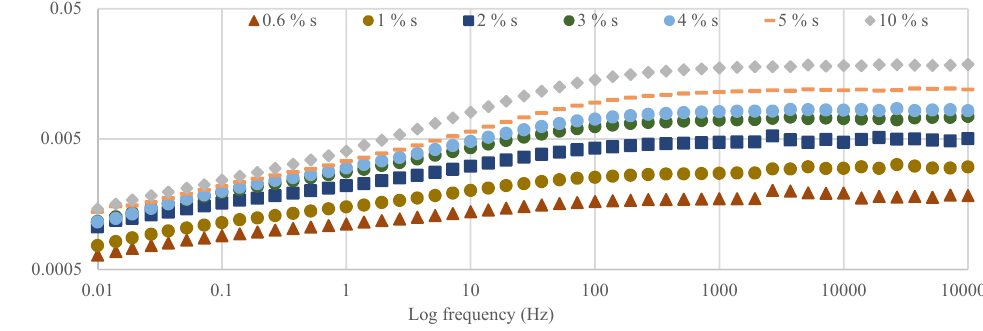
Figure 4. Conductivity of N solution (0.6%, 0.8%, 1.0%, 2.0%, 3.0%, 4.0%, 5.0%, and 10.0%) at a frequency range of 0.01 Hz to 100